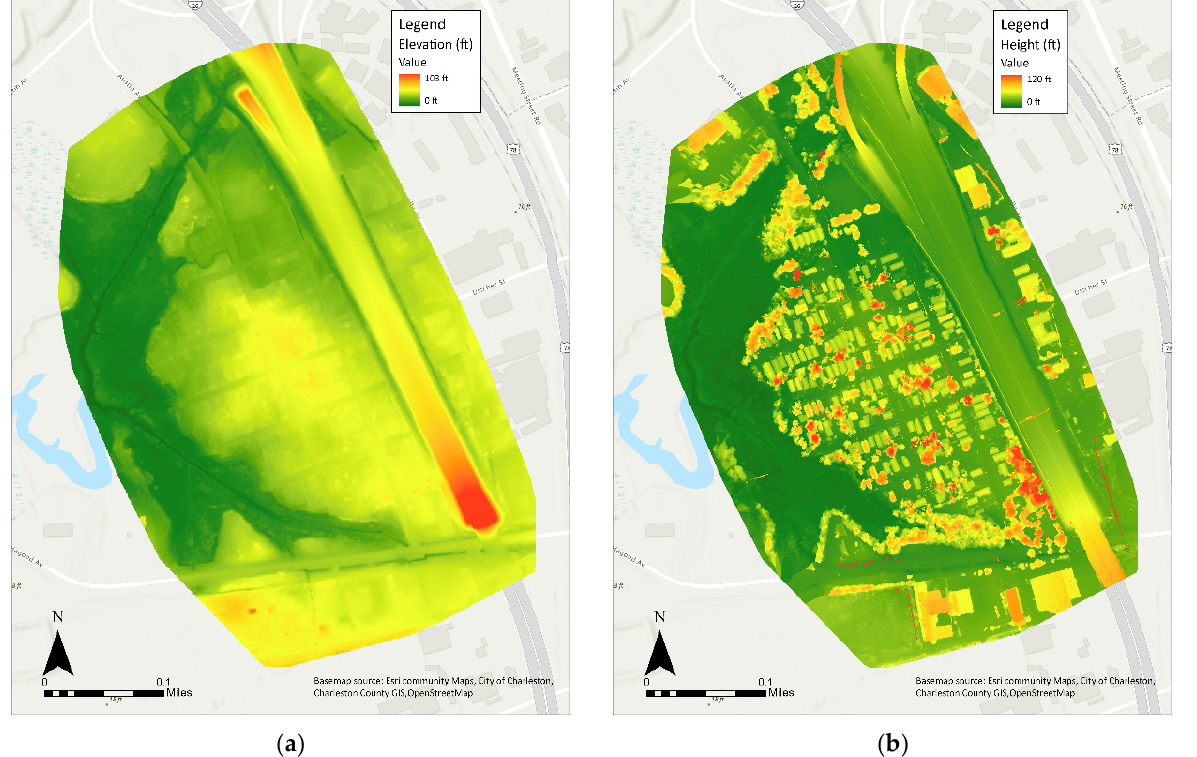
Figure 13. ( a ) Lidar-based Digital Elevation Model (DEM) depicting elevation in Rosemont elevation. Elevation data are in feet above sea level [NAVD88]. ( b ) Drone-based Digital Surface Model (DSM) depicting elevation and building heights in Rosemont. Elevation data are in feet above sea level [WGS84]. (Lidar and Drone data Developed by the College of Charleston, Lowcountry Hazards Center). Black line in ( b ) alongside I-26 is the new sound wall shown in Figure 12. The I-26 highway is shown entering the bottom right corner of each figure and proceeding diagonally across the figure.